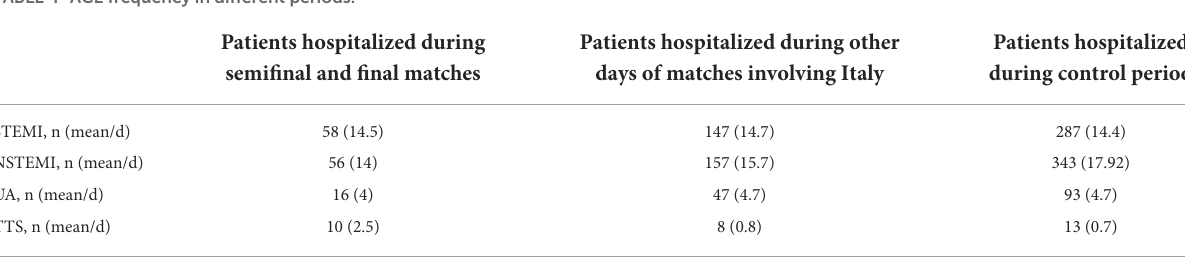
TABLE 4 ACE frequency in different